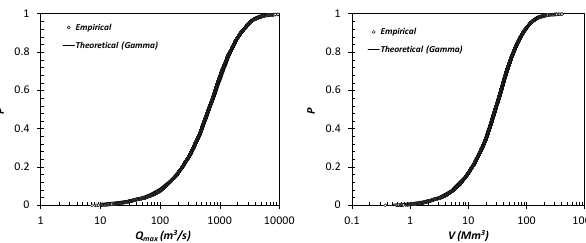
Figure 14. Plotting position: flood peak and volume.